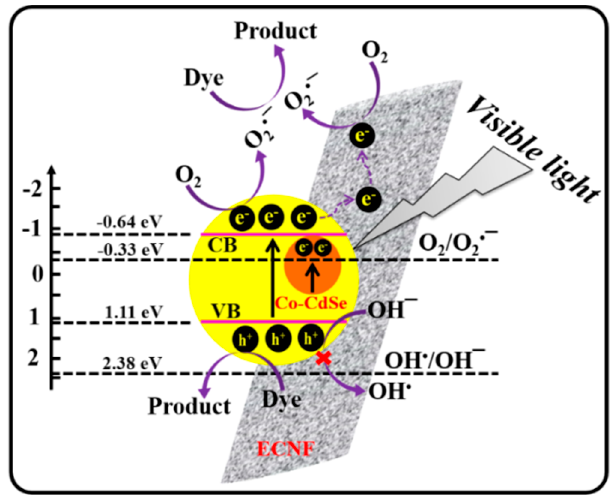
Figure 11. Schematic illustration for the photodegradation of dye solution using proposed Co-CdSe@ECNFs.